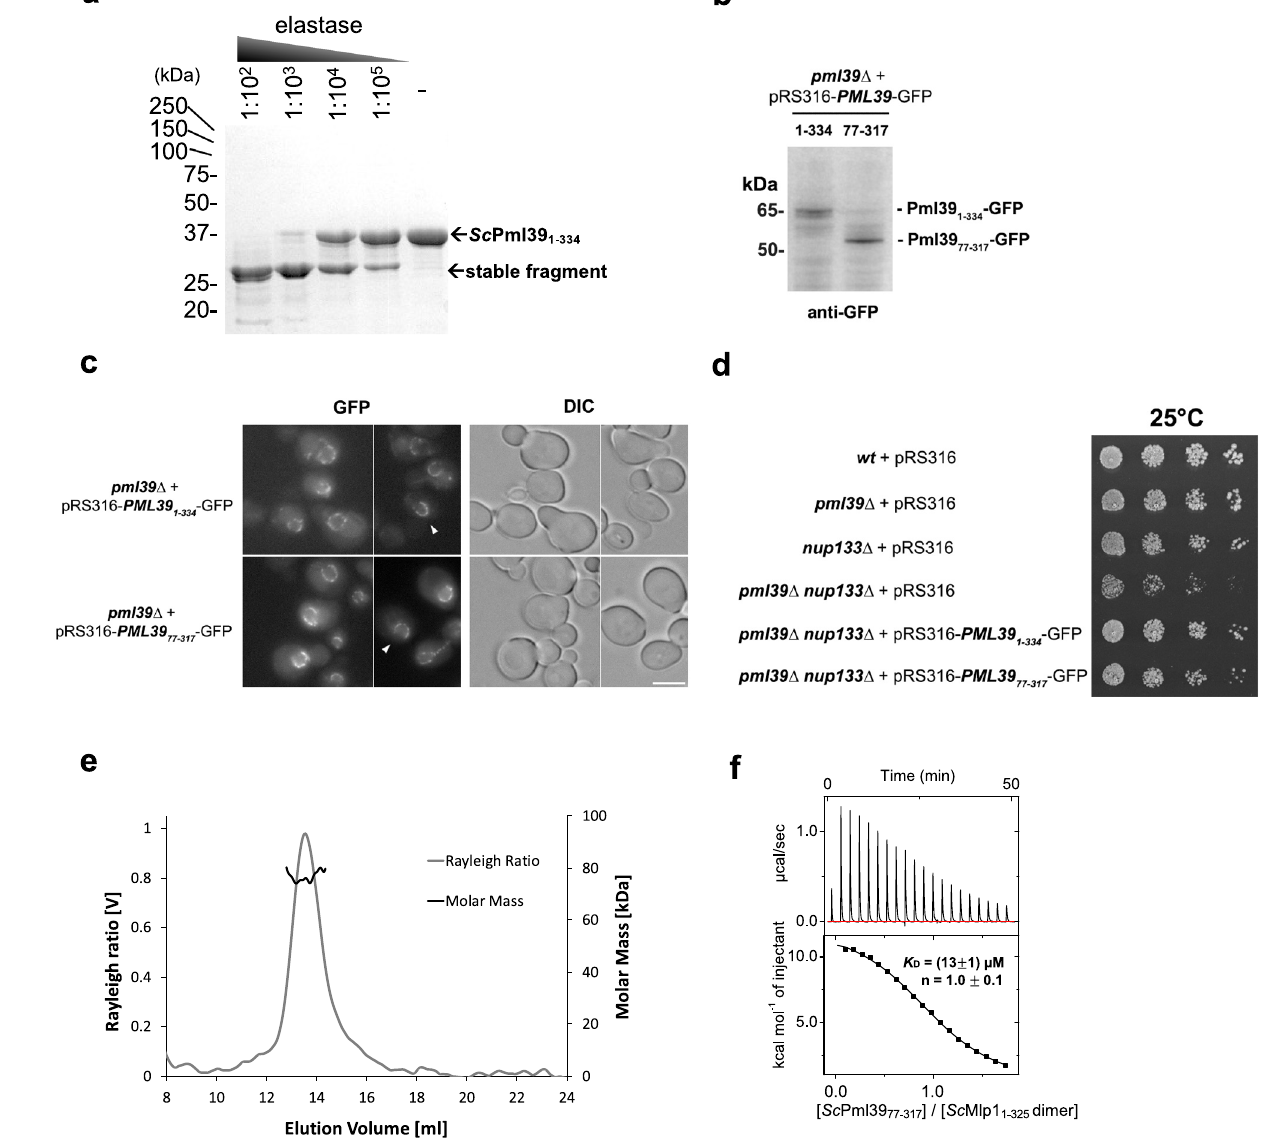
Figure 1. Sc Pml39 contains a single domain that recapitulates subcellular localization, function, and Sc Mlp1- interaction of full-length Sc Pml39. ( a ) Limited proteolysis of recombinant full-length Sc Pml39 at the indicated dilutions of 2 mg/ml elastase analyzed by SDS-PAGE. The full-length version of the cropped gel is presented in Fig. S4a. ( b ) Expression of GFP-tagged full-length (1–334) or truncated (77–317) versions of Sc Pml39 in pml39Δ cells detected by immunoblotting using anti-GFP antibodies. The full-length version of the cropped blot is presented in Fig. S4b. ( c ) Live imaging of pml39Δ cells expressing GFP-tagged full-length (1–334) or truncated (77–317) versions of Sc Pml39. Single plane images are shown for the GFP and DIC (differential interference contrast) channels. Arrowheads point to nuclei showing the U-shaped perinuclear staining typical of Sc Pml39. Scale bar, 5 µm. ( d ) Cells of the indicated genotypes were spotted as serial dilutions on SC medium and grown for 3 days at 25 °C. ( e ) Recombinant Sc Mlp1 1–325 forms a homodimer. Size exclusion chromatography coupled to multi-angle light scattering (SEC-MALS) using a Superdex 200 10/300 column was used. Molecular mass determination and Rayleigh ratio of Sc Mlp1 1–325 (dark and light gray, respectively) demonstrated that the Sc Mlp1 1–325 (expected molecular size is 41 kDa) has a dimeric size (~ 80 kDa). ( f ) Isothermal titration calorimetry (ITC) thermogram (upper panel) and plot of corrected heat values (lower panel) showed that monomeric Sc Pml39 77–317 binds dimeric Sc Mlp1 1–325 at a 1:1 molar ratio with a K D value of ~ 13